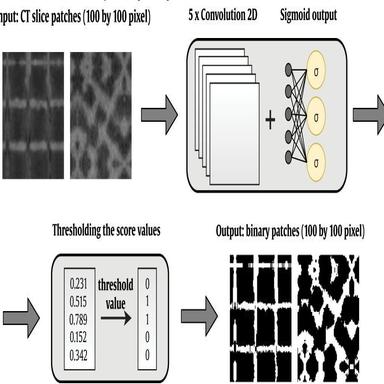
Segmentation pipeline of CT-Scans of microarchitectured metal structures.